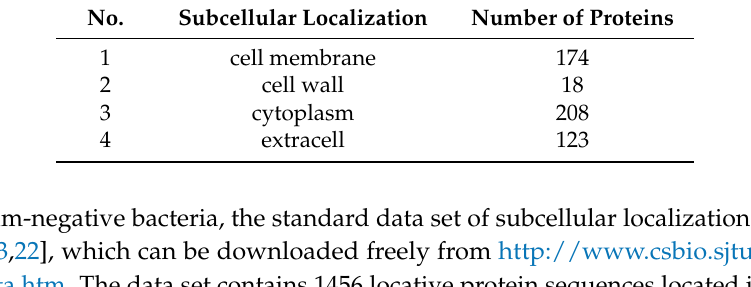
Table 6. The name and the size of each location for the Gram-positive data set.